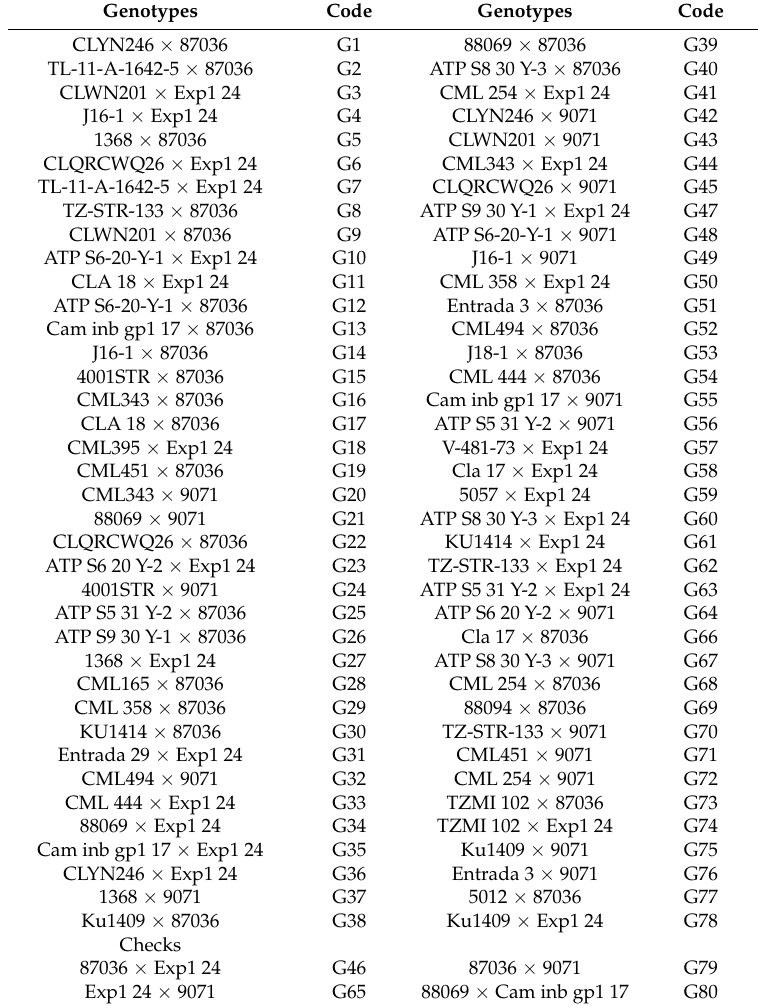
Table 1. Names and codes of 80 single cross hybrids evaluated across 11 environments in 2012 and